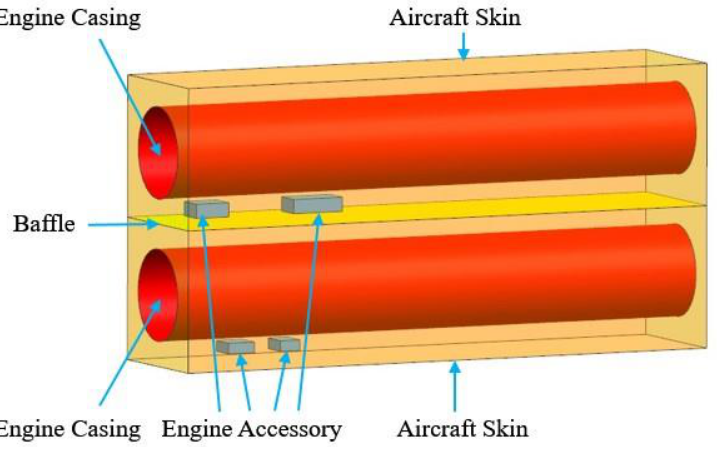
Figure 1. Structure of the engine cabin and accessories.